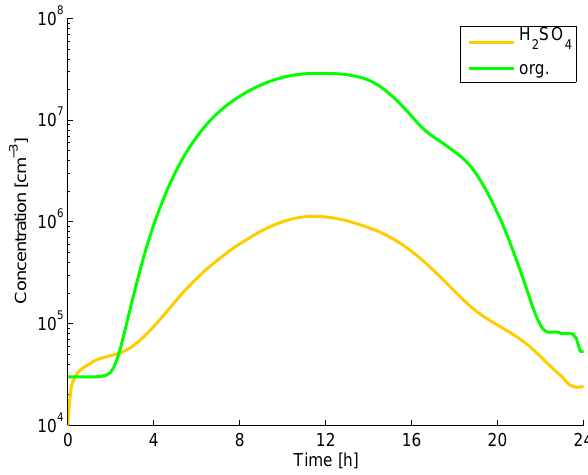
Fig. 1. The concentrations of sulphuric acid and a non-volatile or- ganic vapour used in the simulations. Note that as the concentration of the organic vapor is significantly higher than that of sulphuric acid, the organic vapor will cause most of the growth in